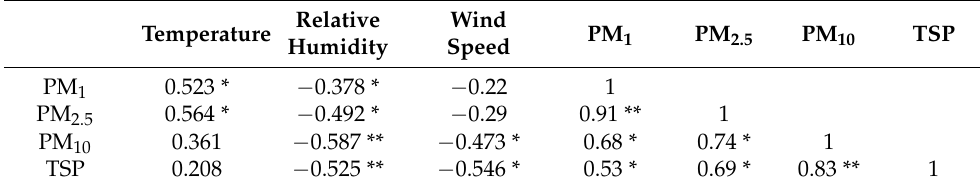
Table 3. Pearson correlation coefficients between PM (TSP, PM 10 , PM 2.5 , and PM 1 ) concentrations and the corresponding potential influential factors (temperature, relative humidity, and wind